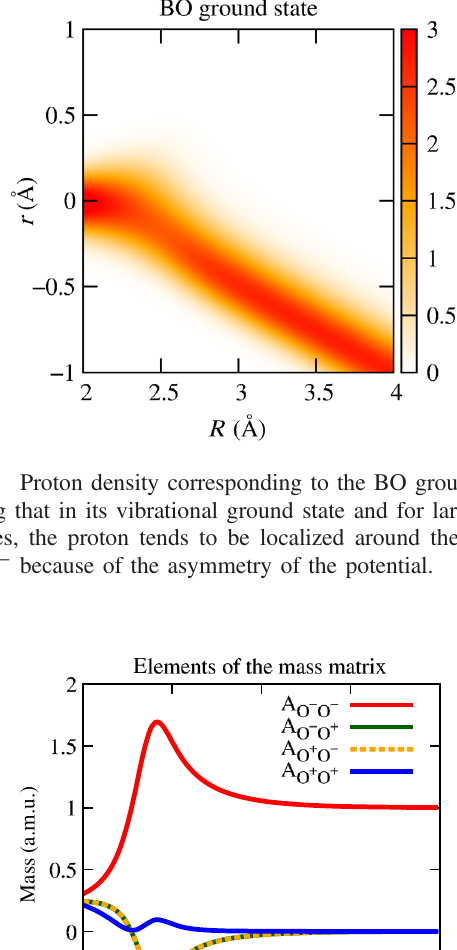
FIG. 3. Elements of the A matrix as functions of R . As expected, for a large O ─ O distance, the proton mass associated with the oxygen O − tends to unity, while all other contributions tend to zero since the proton localizes around O − .